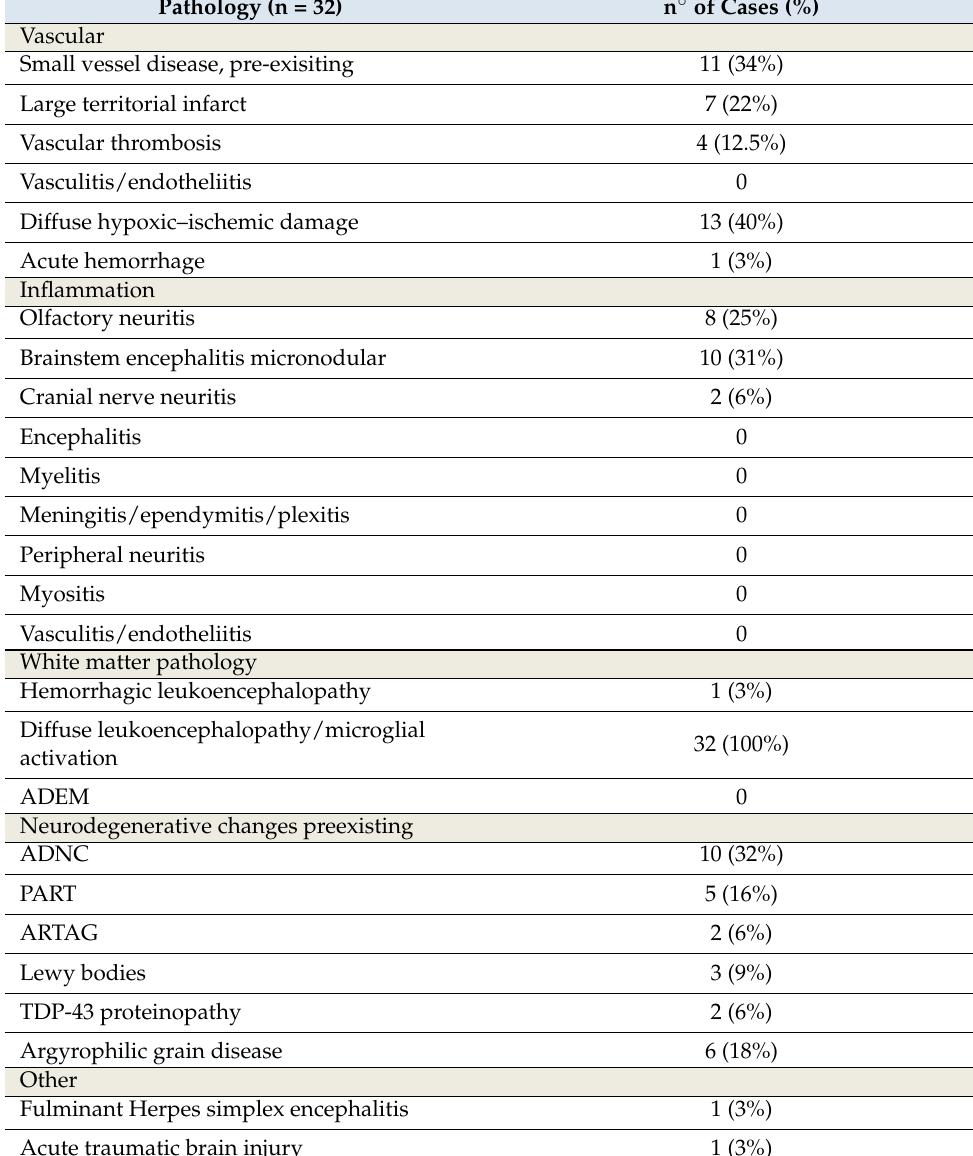
Table 4. Summary of neuropathological